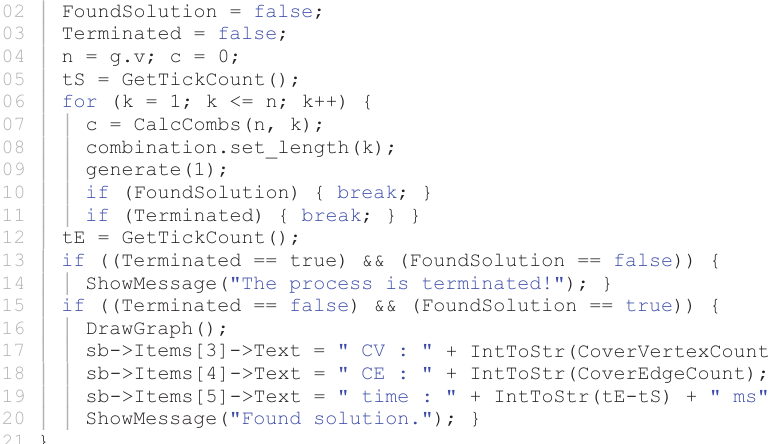
Fig. 2. Source code of the BTR algorithm based on the backtracking